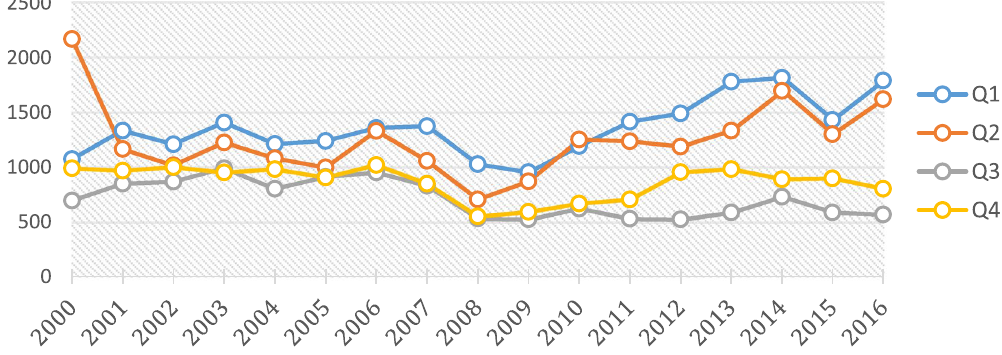
Figure 2. Mean seasonal/quarterly malaria transmission